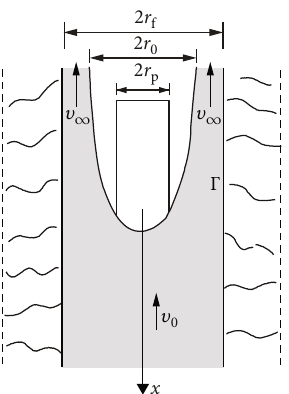
Figure 4: Diagram of the calculation model of crater